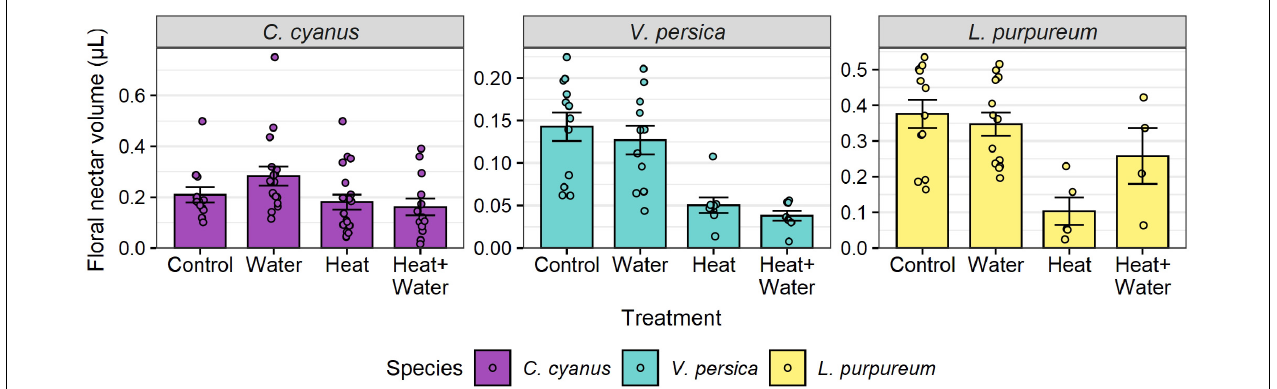
FIGURE 1 | Raw nectar volumes per flower for each treatment, for three wildflower species. Bars and error-bars represent mean ± s.e. Points show the individual samples. Many flower buds were damaged or failed to open after being bagged, leading to uneven and smaller sample sizes than the target of 30 per treatment (see Supplementary Table 3